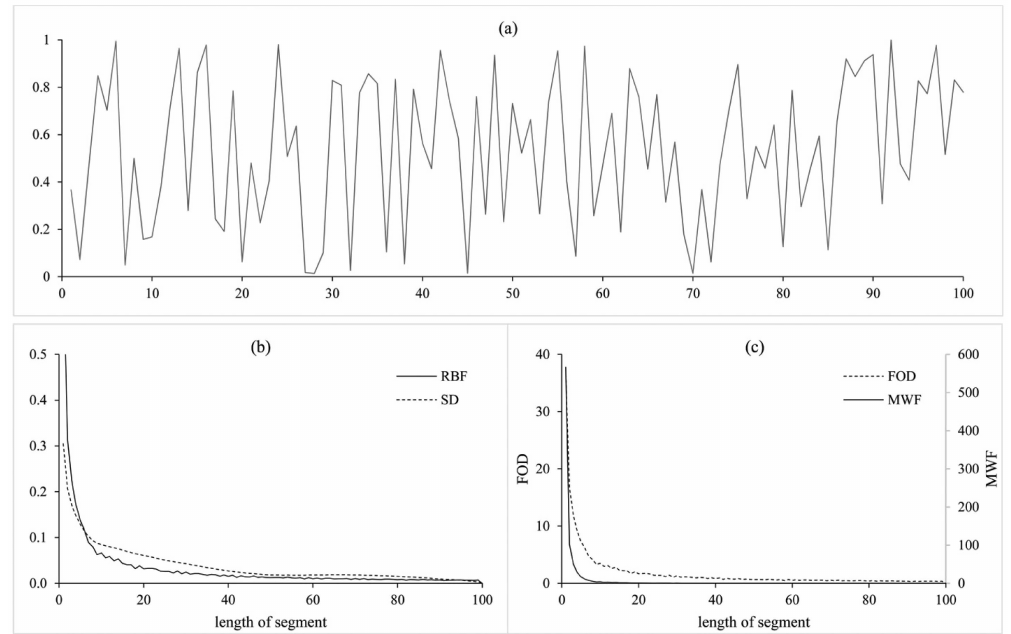
Figure 7. Comparison of indices with different moving average disposals. ( a ) a random process with 100 data points and its ordinates range from 0 to 1; ( b ) the RBF or SD indices of disposed process with segment length ranging from 2 to N ; ( c ) the FOD or MWF indices of disposed process with segment length ranging from 2 to N .